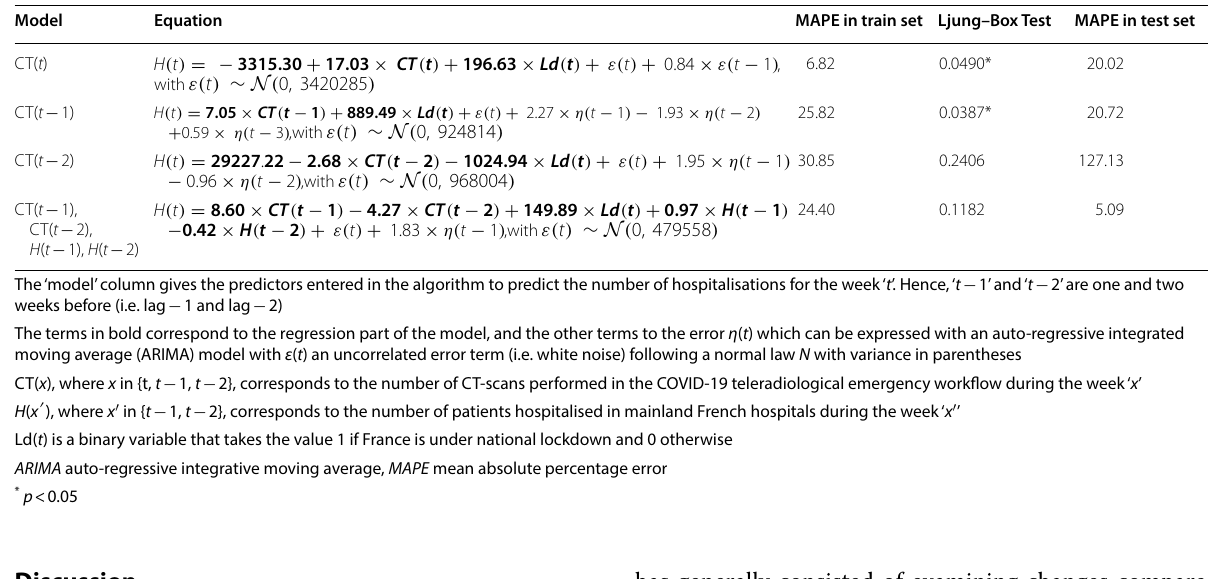
Table 4 Final predictive